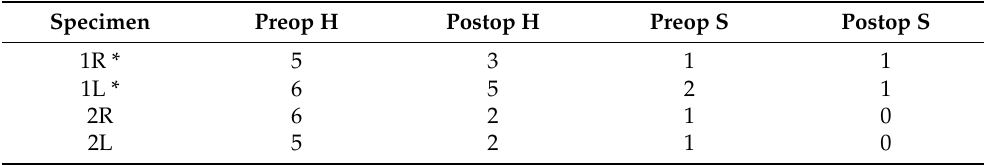
Table 2. Position changes of the sesamoid before/after the MPO and proximal metatarsal osteotomy (except for specimen 2), based on 2 classifications: Hardy and Clapham’s tibial sesamoid 7 position system (H) and Smith’s tangential 4 position (S). The sesamoid position of the 1R specimen did not improve because the proximal phalanx was cut distally.